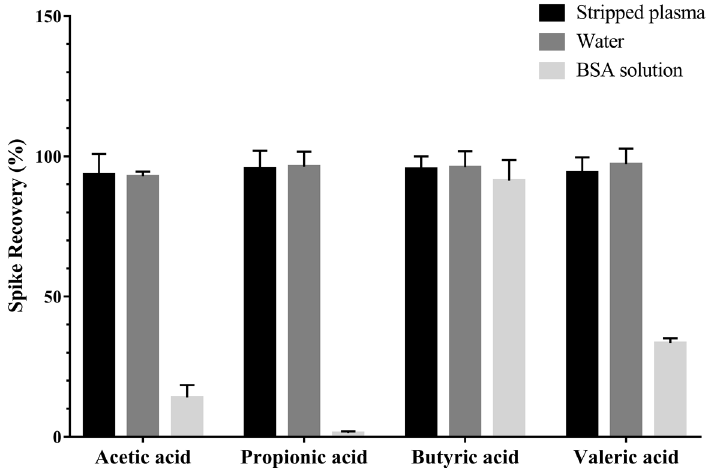
Figure A3. Spike recovery of SCFAs between surrogate matrix candidates and plasma ( n = 3, mean ± standard deviation).